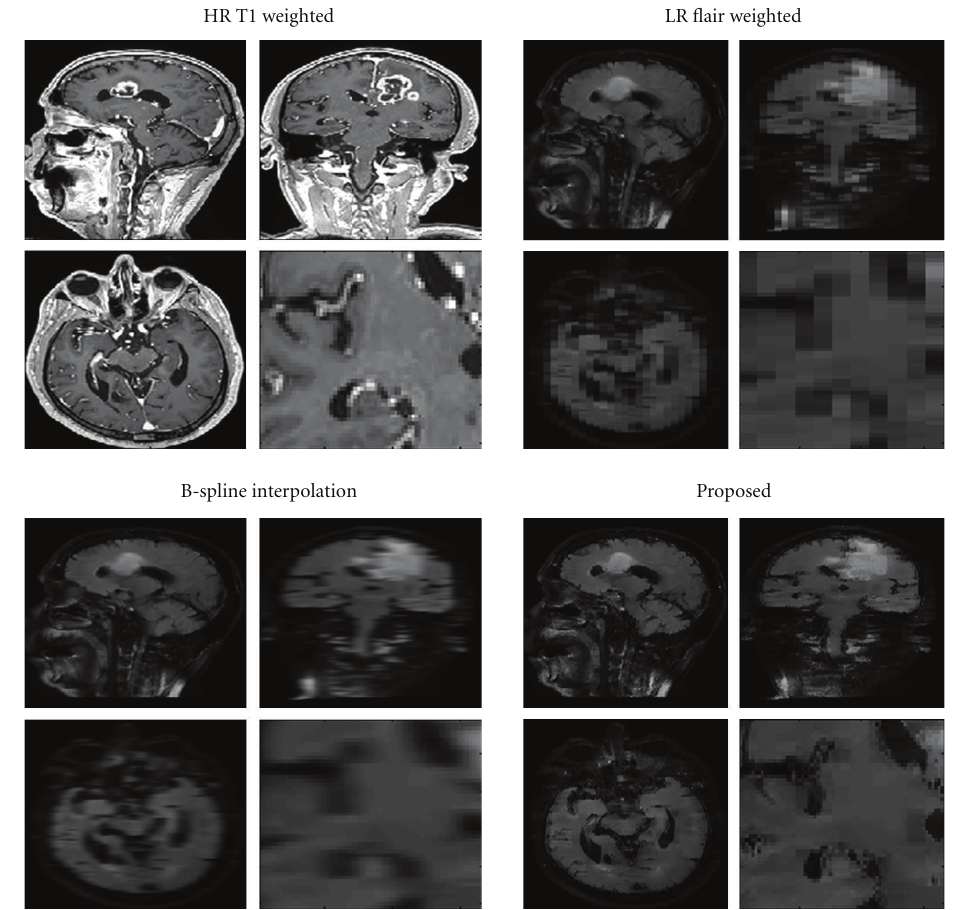
Figure 8: Comparison of real clinical data experiment. Top-Left: HR T1 data. Top-Right: LR FLAIR volume. Bottom-left: B-Spline reconstruction. Bottom-right: reconstruction using the proposed method. In each case a close-up of the coronal slice is presented to better show how the proposed method provides a less blurry